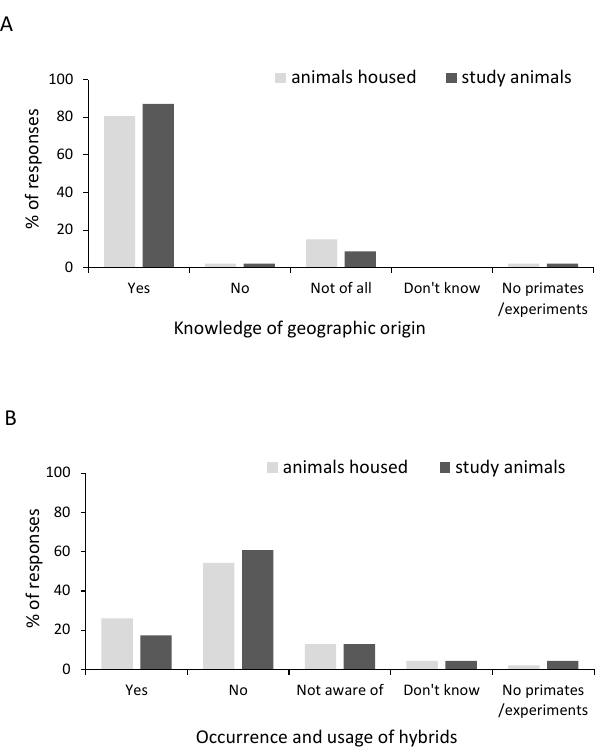
Figure 1. Knowledge of (a) geographic origin of primates housed and used in experiments, and (b) occurrence and usage of hybrids at represented facilities ( N = 46).